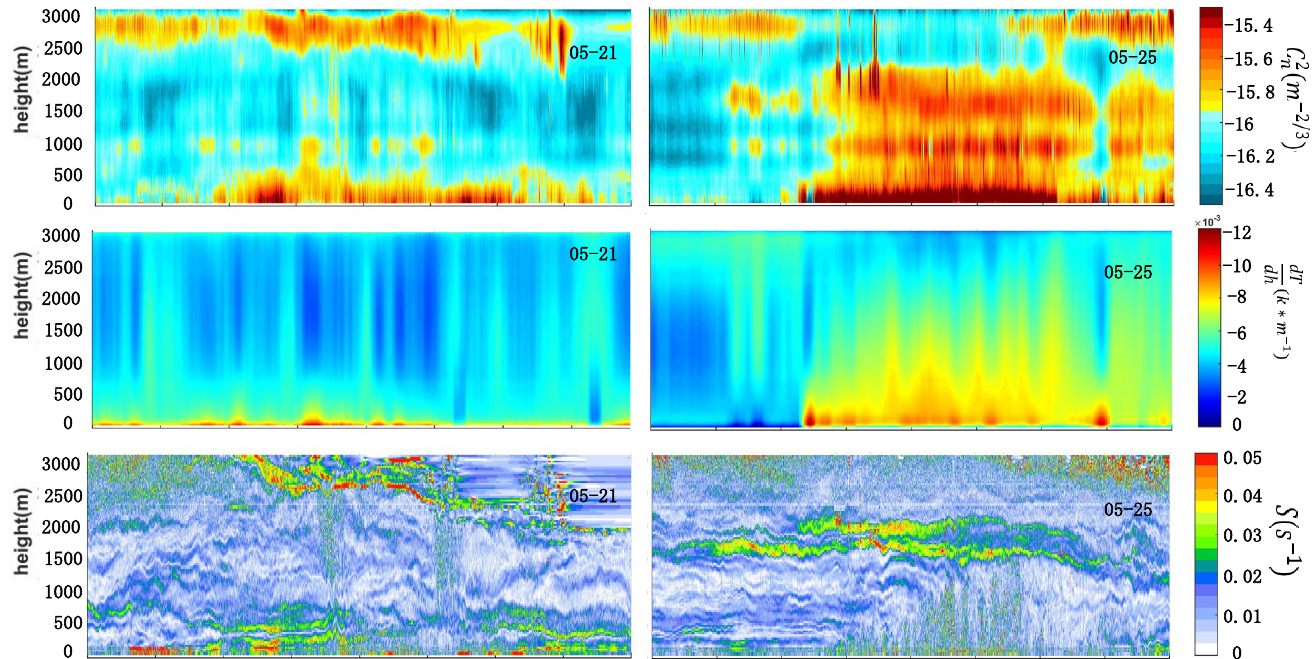
2 C , dT , and S in two days. Figure 8. Spatiotemporal distribution of C 2 n , dT dh , and S in two n dh